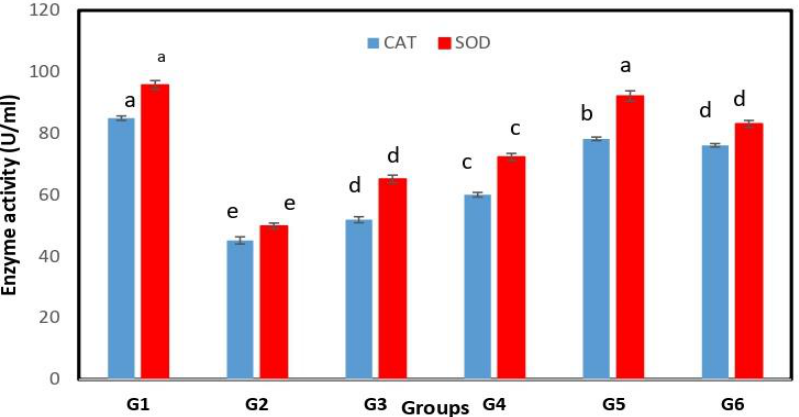
Figure 2. Effect of Spirulina maxima extract, Lactobacillus casei ATCC 7469-fermented wheat bran extract and their combination on liver oxidative enzymes of Sprague – Dawley rats at 7 weeks. G1: Regular diet (R.D.); G2: High-fat diet (HFD); G3: HFD+ Spirulina maxima extract G4: HFD+ Lactobacillus casei ATCC 7469 fermented wheat bran extract; G5: HFD+ combination of Spirulina maxima extracts and Lactobacillus casei ATCC 7469 fermented wheat bran extract; G6: HFD+ rosuvastatin. The results are expressed as the means ± SD ( n = 5). Bars with different superscripts are significantly different ( p < 0.05).